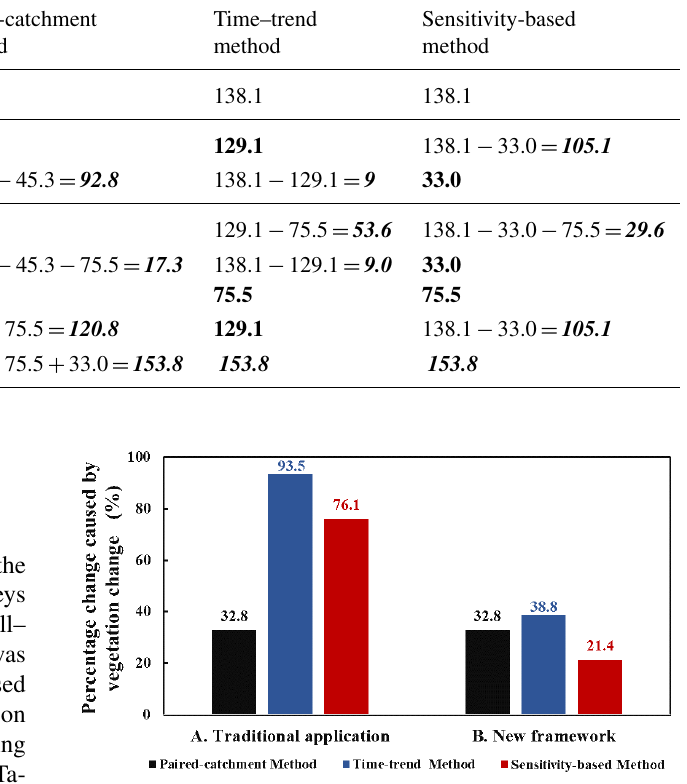
Figure 6. The contribution of vegetation change to the total runoff changes of the Red Hill catchment, New South Wales, Australia, estimated using this three methods under the traditional application and the new